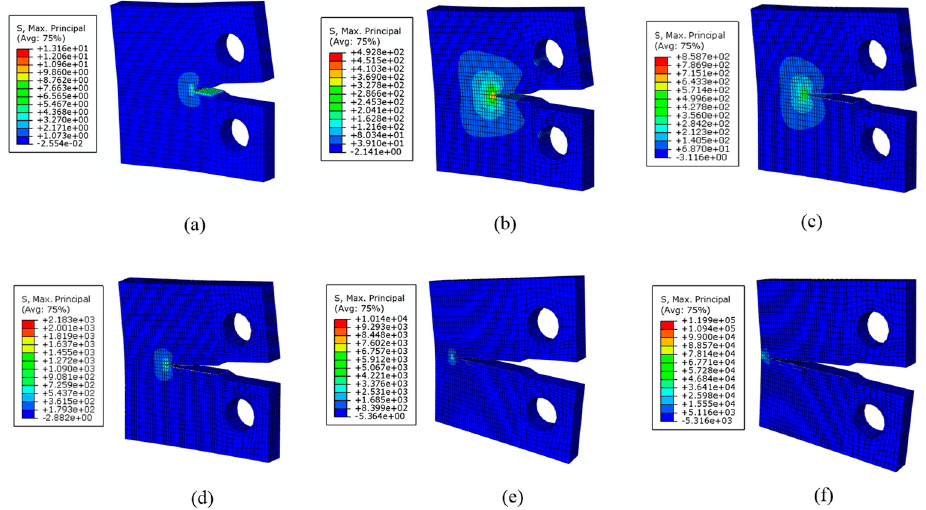
Figure 10. Stress distribution of the FCP process. ( a ) a = 10 mm, N = 1; ( b ) a = 18 mm, N = 1.59E 5 ; ( c ) a = 26 mm, N = 2.21E 5 ; ( d ) a = 34 mm, N = 2.7E 5 ; ( e ) a = 42 mm, N = 3.04E 5 ; ( f ) a = 50 mm, N = 3.49E 5 .